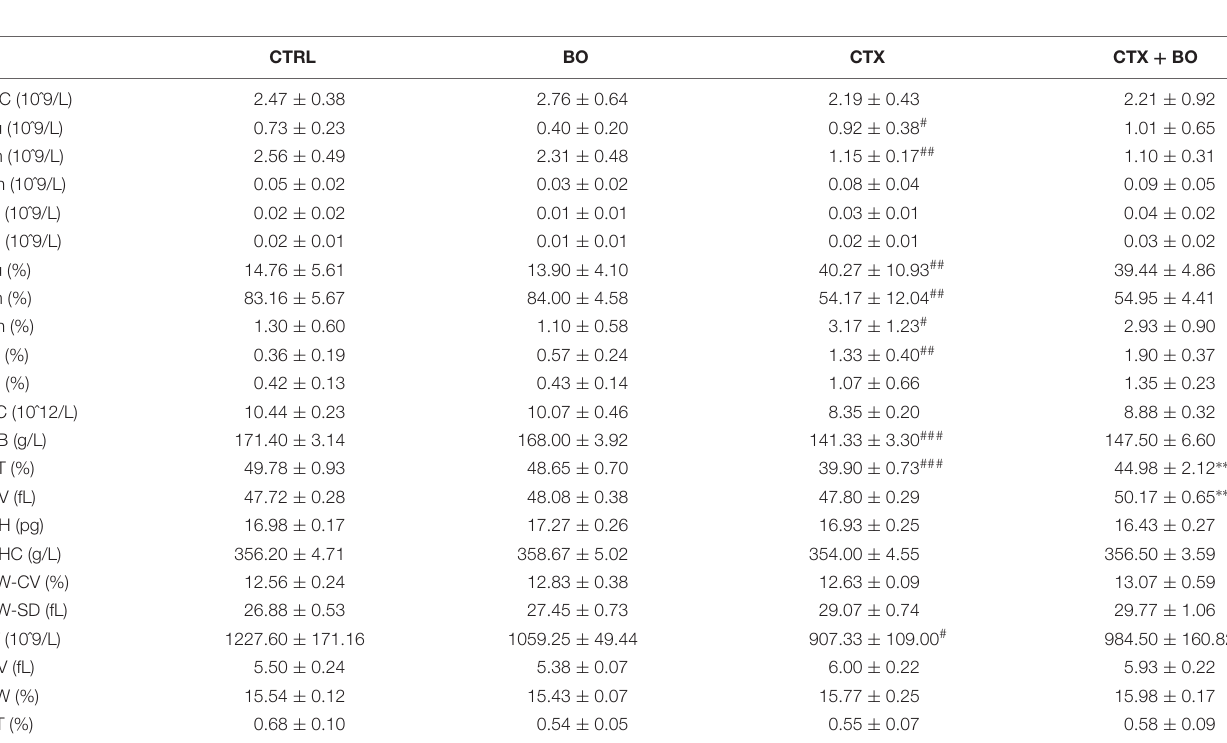
TABLE 3 | Profiles of (A) hematological values and (B) liver parameters in immunocompetent and immunosuppressed mice after 5-day treatments with B. ovatus